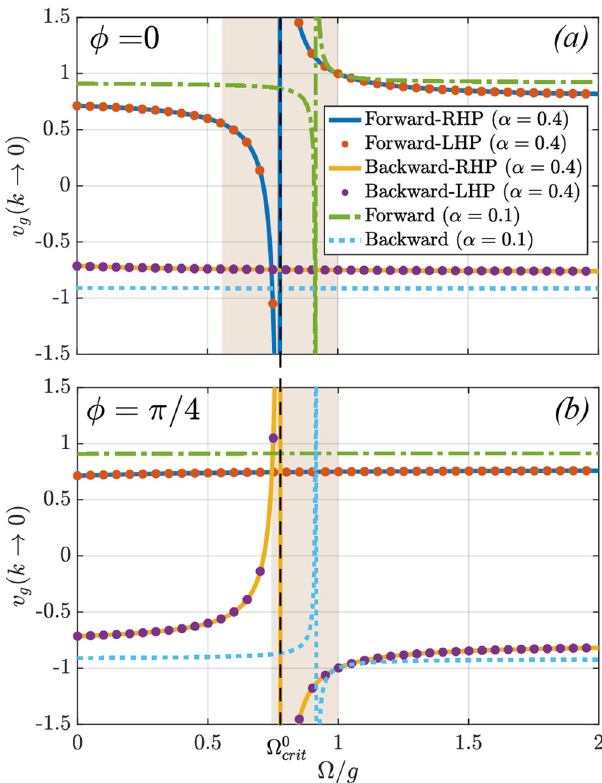
Fig. 5 Long-wavelength (k → 0) velocity of the bands across all velocity regimes for half-dephasing (a) ϕ = 0 and (b) ϕ = π /4. Continuous lines and circles are for α = 0.4, whereas the dashed and dotted lines are for α = 0.1, demonstrating the shrinking of the velocity range over which the interaction with the screw is strongest. Note that for ϕ = 0 the screw interacts signi fi cantly only with the forward bands, whereas the opposite occurs for ϕ = π /4. Note that the slopes of RHP and LHP bands are always degenerate in the k → 0 limit, as a consequence of PT symmetry. Shaded regions correspond to velocity regimes comprised between the exceptional points Ω (cid:2) and Ω þ (for the α = 0.4 case), while the critical point Ω 0 crit crit for α = 0.4), common to both the ϕ = 0 and ϕ = π /2 cases, is marked as a black, dashed